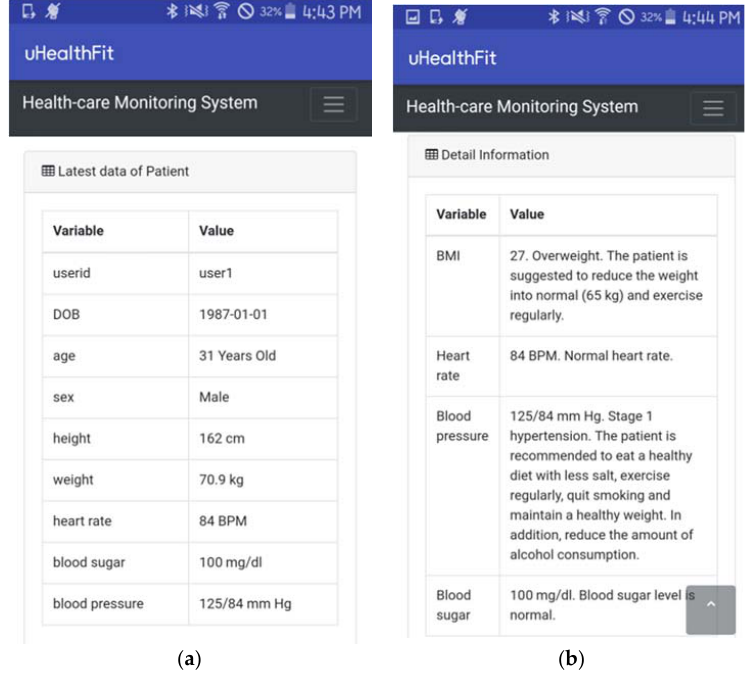
Figure 10. ( a ) The healthcare app showing the current user’s health data and ( b ) healthcare suggestions.